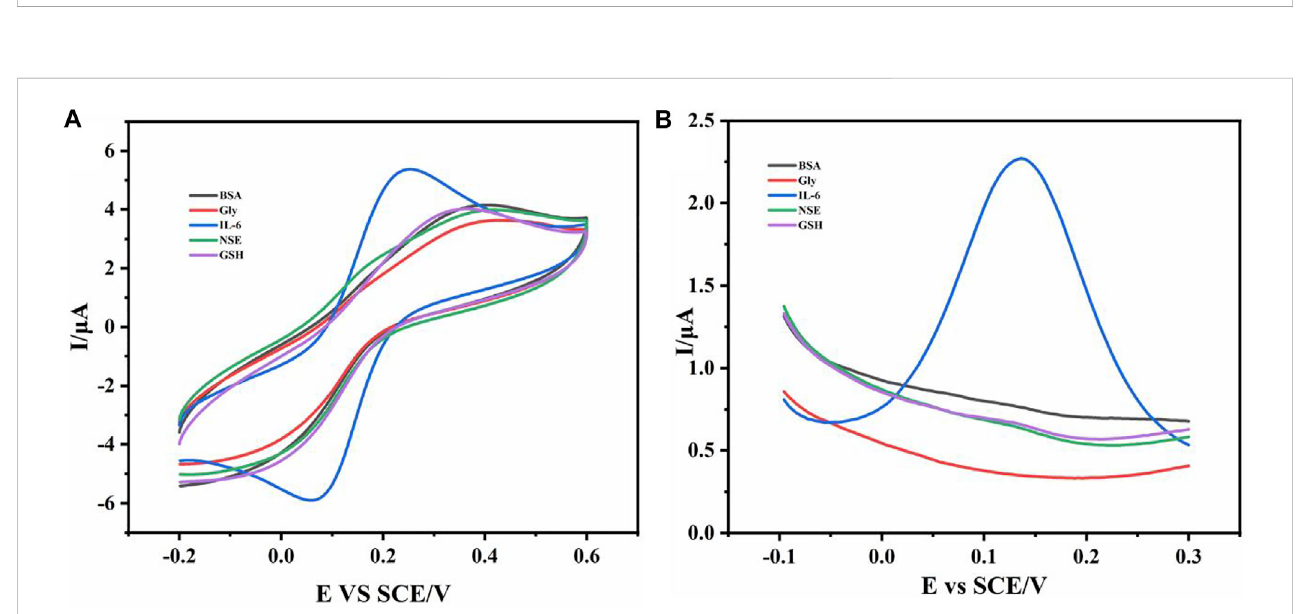
FIGURE 2 The CV curve (A) and DPV curve (B) of different substances (BSA, Gly, GSH, NSE, and IL-6) were